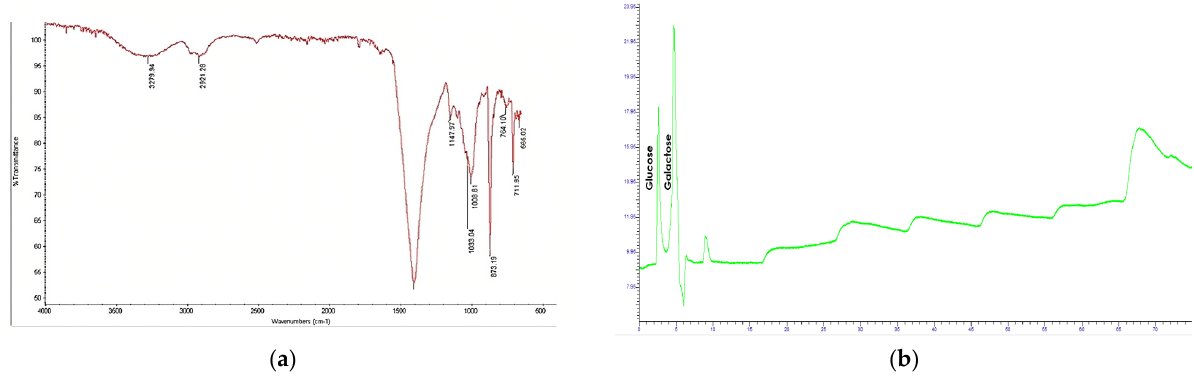
Figure 4. ( a ) Fourier transform infrared (FTIR) spectrum of EPS isolated from Acinetobacter sp. ( b ) Monomer composition analysis of CUI-P1 exopolysaccharides by